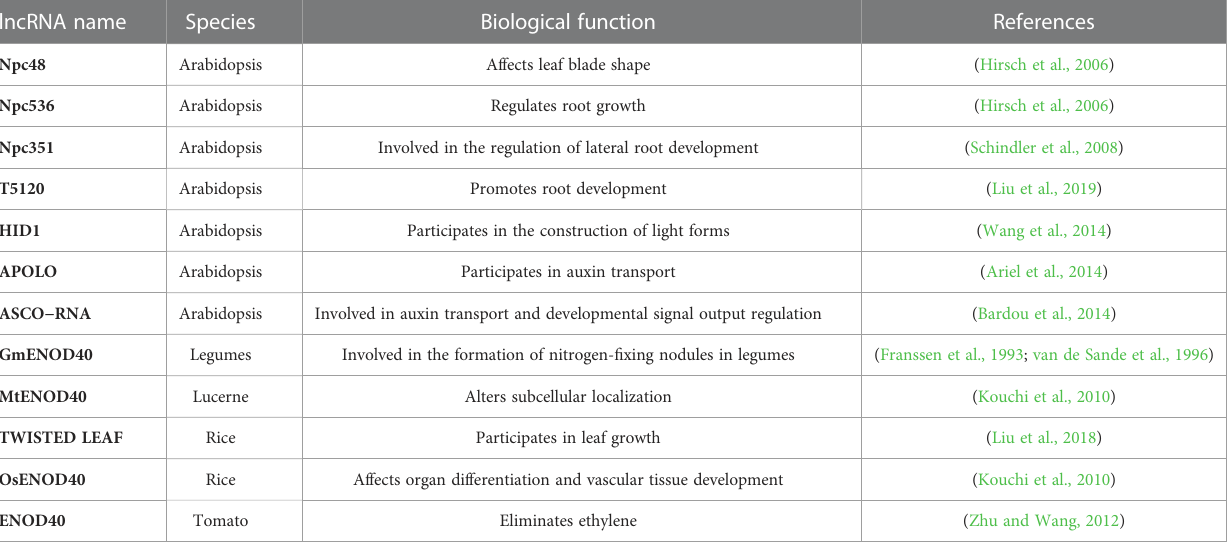
TABLE 1 lncRNAs involved in vegetative growth.